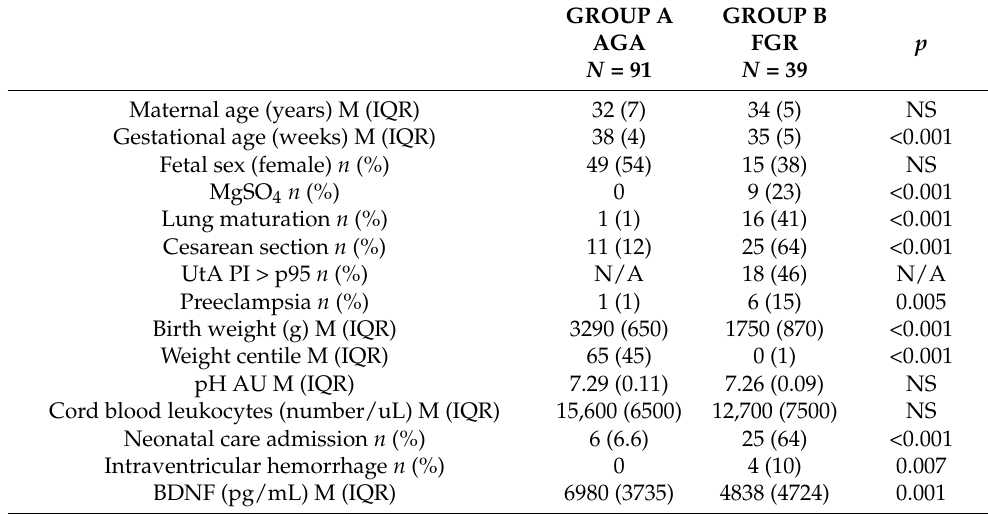
Table 1. Bivariate analysis of maternal and neonatal clinical characteristics of the study